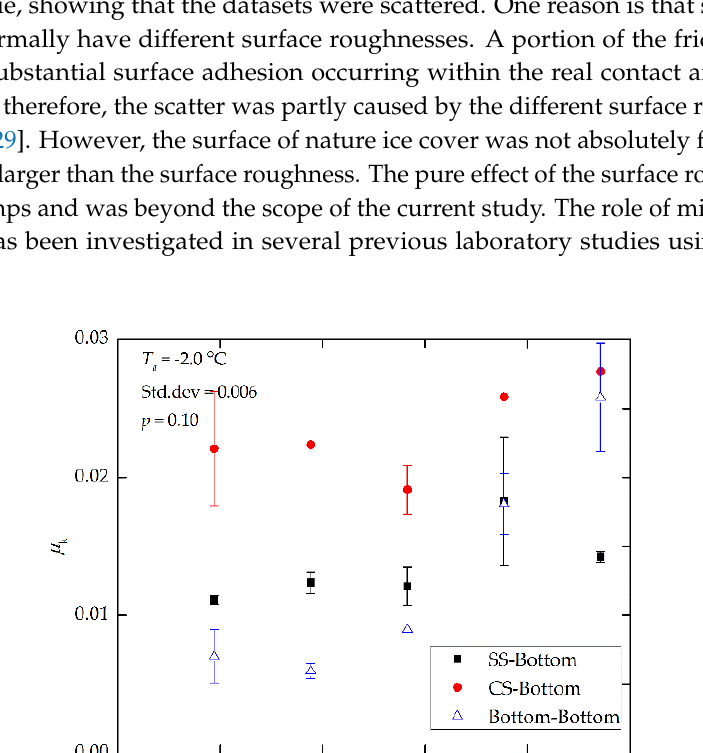
Figure 10. Variations of μ k with velocity V for SS-ice, CS-ice, and ice-ice contacts. The data at a given velocity were the mean values over different test conditions, and the error bars represent the standard deviation.